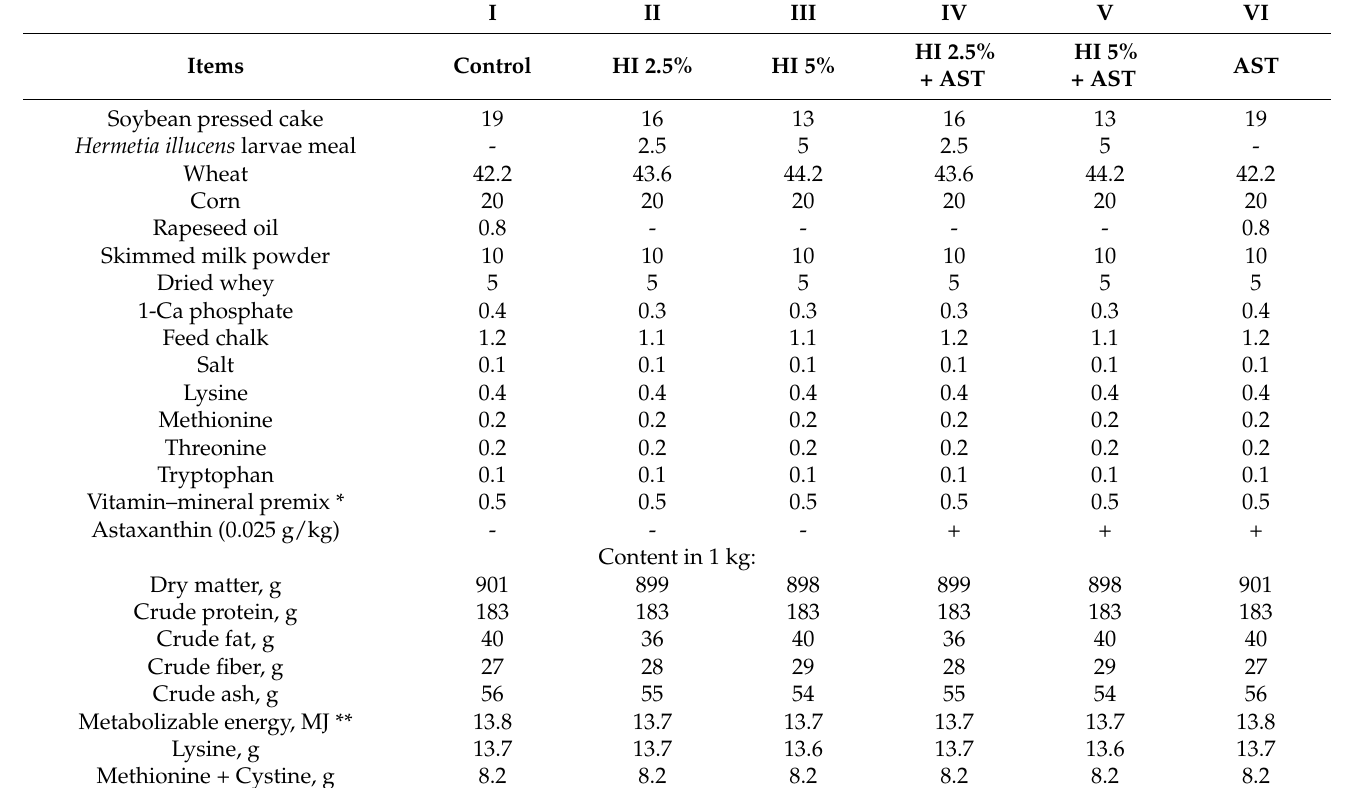
Table 1. Ingredients (%) and nutritive value of diets in the